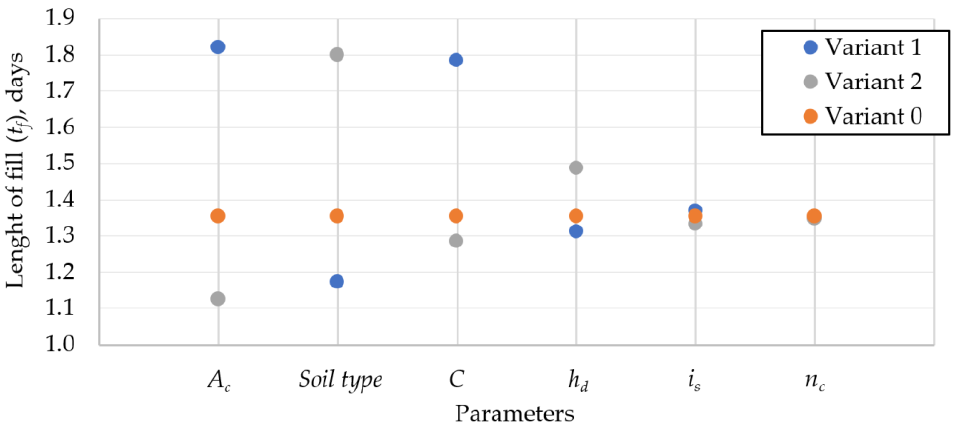
Figure 15. The length of fill of the infiltration facility above the value of h imax = 0.3 m in the period from 1 January 2011 to 30 June 2022 (designations as in Figure 2).